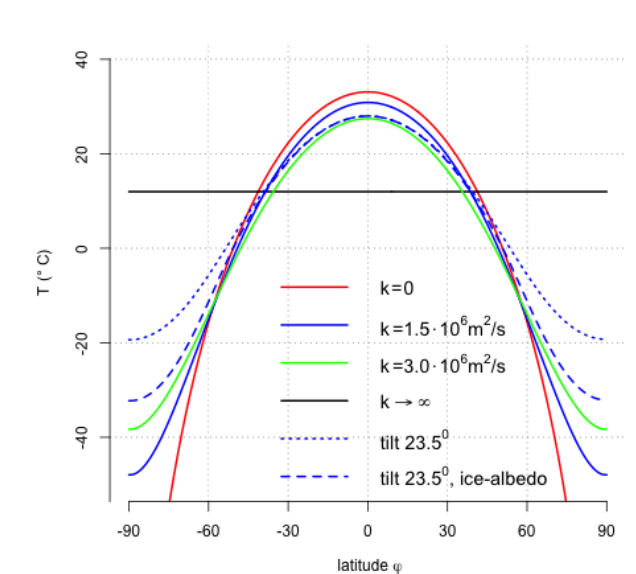
Figure 6. Equilibrium temperature of Eq. (16) using different dif- fusion coefficients ( C p = C a p ) . The blue lines use 1 . 5 × 10 6 m 2 s − 1 with no tilt (solid line), a tilt of 23 . 5 ◦ (dotted line), and a tilt of 23 . 5 ◦ with ice–albedo feedback using the representation of Sellers (1969) (dashed line). Except for the dashed line, the global mean values are identical to the value calculated in Eq. (13). Values are given in ◦ C.